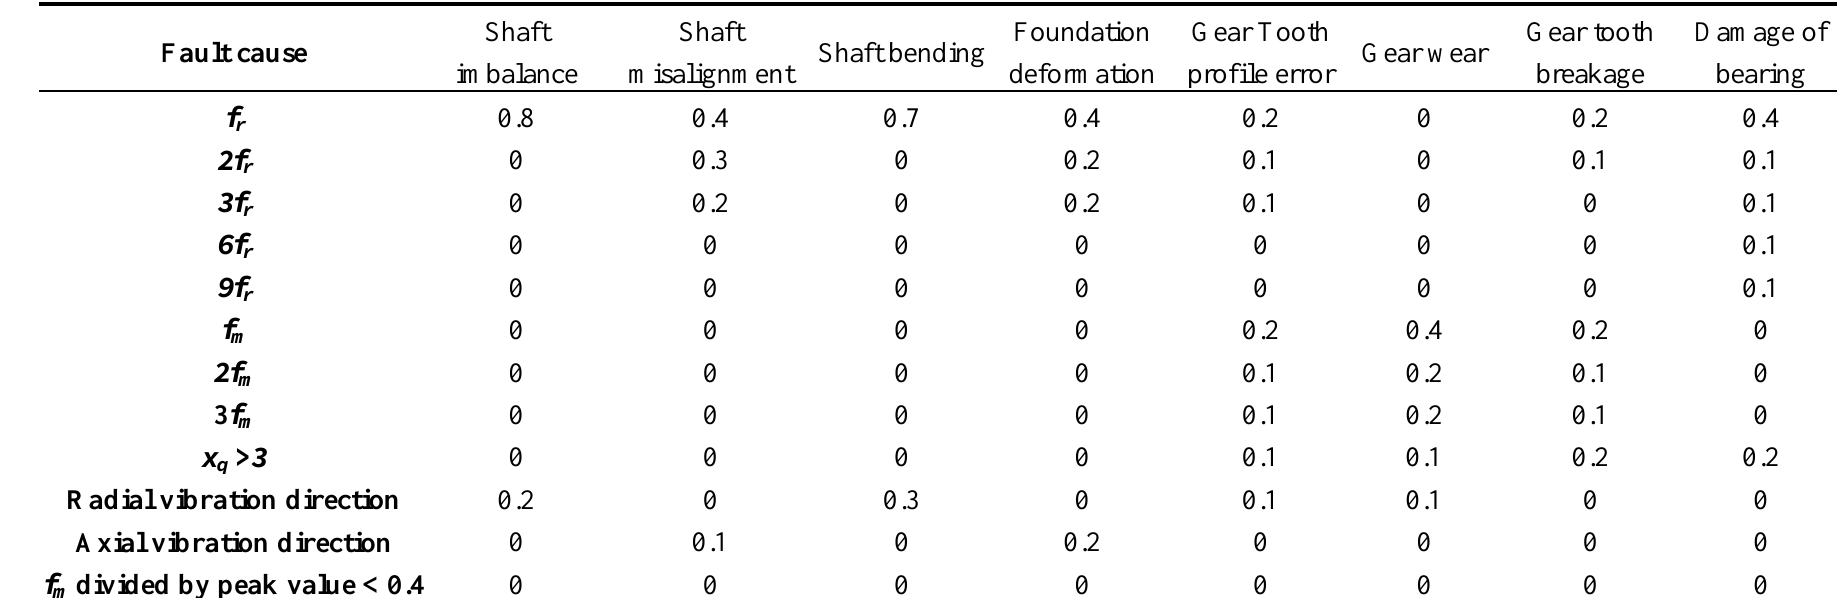
Table 1. The rules of